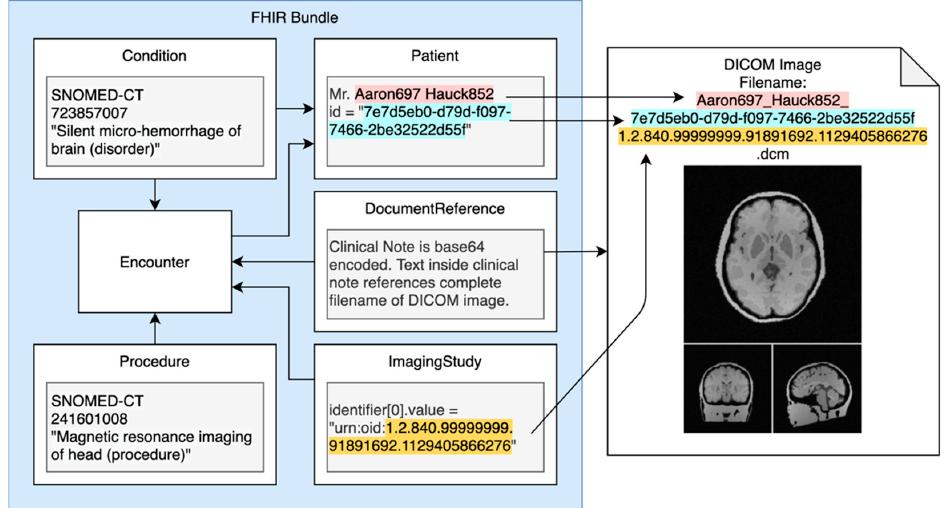
Figure 3. Relationship of FHIR Resources and a DICOM image file. An encounter for a synthetic patient that received imaging includes the procedure and imaging study and a reference to the external DICOM image file.